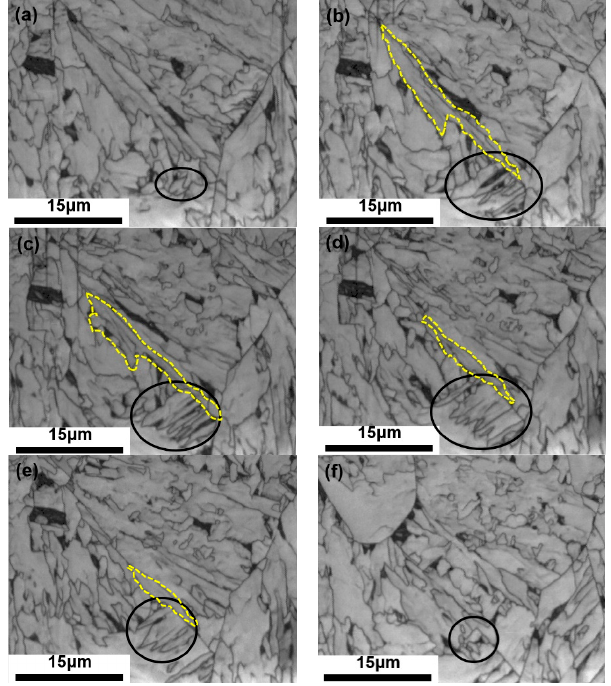
Figure 8. 2D SEM image of the secondary Widmanstätten sideplate cutting process. ( a ) 51st layer, ( b ) 59th layer, ( c ) 62nd layer, ( d ) 68th layer, ( e ) 72nd layer, ( f ) 93rd layer.